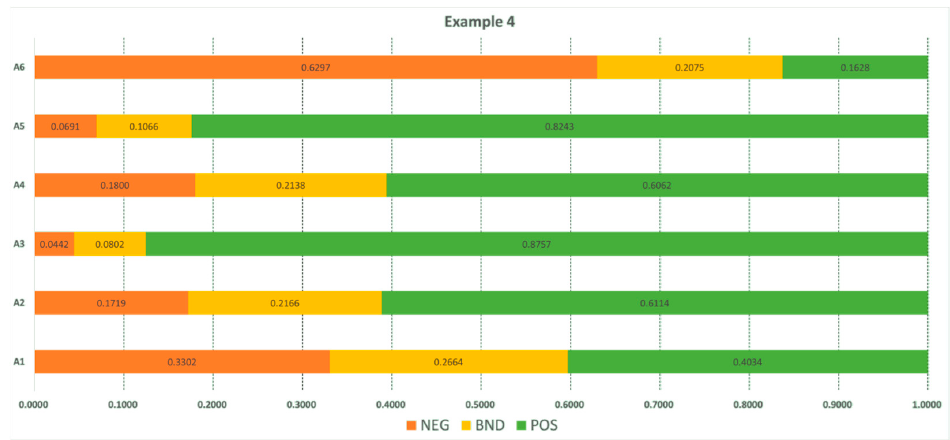
Figure 3. Results of the multi-attribute three-way decisions for Example 4.